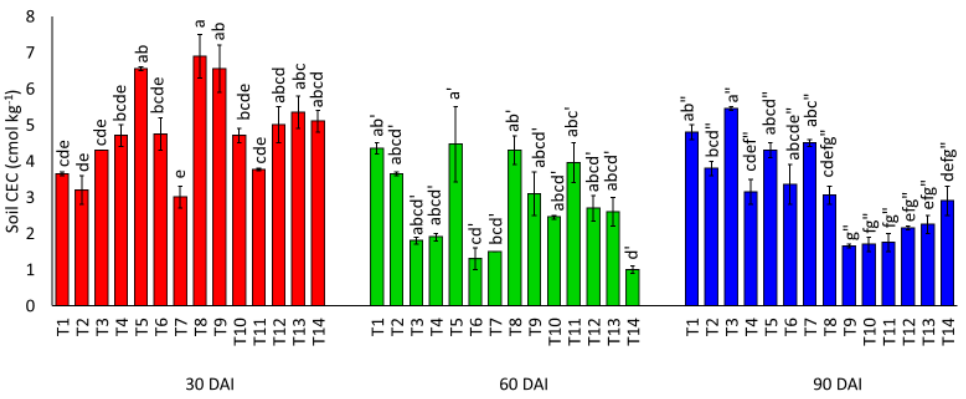
Figure 13. Effects of treatments on soil cation exchange capacity after thirty, sixty, and ninety days of incubation, where T1: soil alone, T2: Egypt rock phosphate alone, T3: Egypt rock phosphate + 100% charcoal, T4: Egypt rock phosphate + 100% sago bark ash, and T5: Egypt rock phosphate + 100% charcoal + 100% sago bark ash, T6: Egypt rock phosphate + 75% charcoal + 75% sago bark ash, T7: Egypt rock phosphate + 50% charcoal + 75% sago bark ash, T8: Egypt rock phosphate + 25% charcoal + 75% sago bark ash, T9: Egypt rock phosphate + 75% charcoal + 50% sago bark ash, T10: Egypt rock phosphate + 50% charcoal + 50% sago bark ash, T11: Egypt rock phosphate + 25% charcoal + 50% sago bark ash, T12: Egypt rock phosphate + 75% charcoal + 25% sago bark ash, T13: Egypt rock phosphate + 50% charcoal + 25% sago bark ash, and T14: Egypt rock phosphate + 25% charcoal + 25% sago bark ash. Means with different letter(s) within the same incubation period indicate significant differences between treatments according to Tukey’s HSD test at p ≤ 0.05, i.e., a > b > c. Bars represent the mean values ± SE.